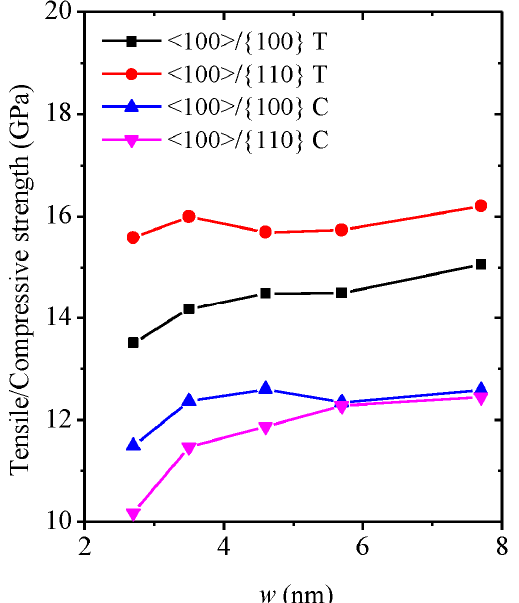
Figure 5. Tensile/compressive strength of silicon nanowires as a function of nanowire width w . The character “T” and “C” designate “tension” and “compression”, respectively.